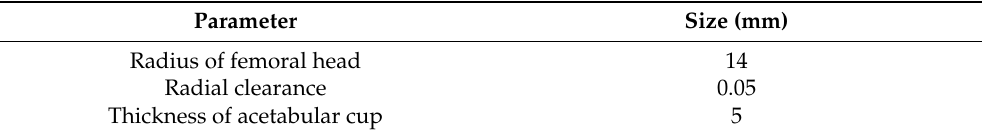
Table 1. Geometry of hard-on-hard bearings.